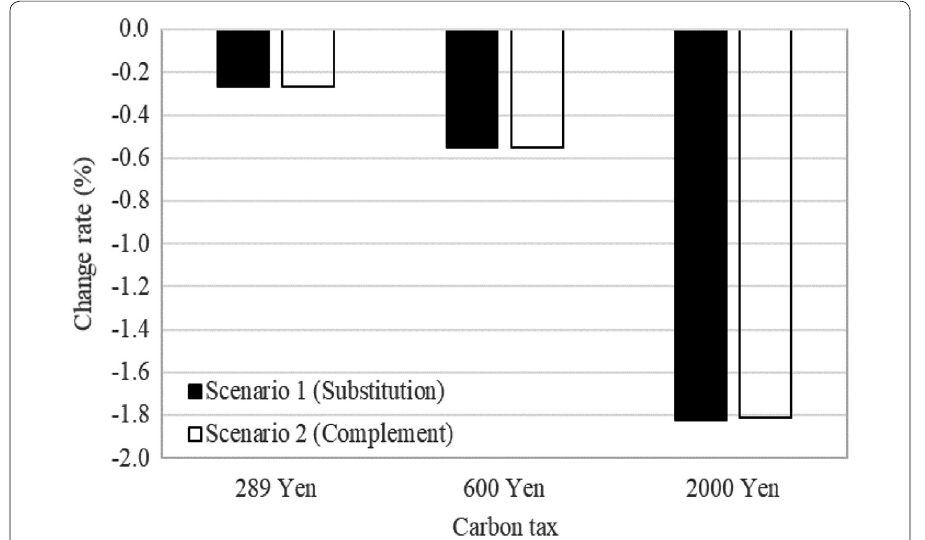
Fig. 5 The change rate of CO 2 emission under the carbon